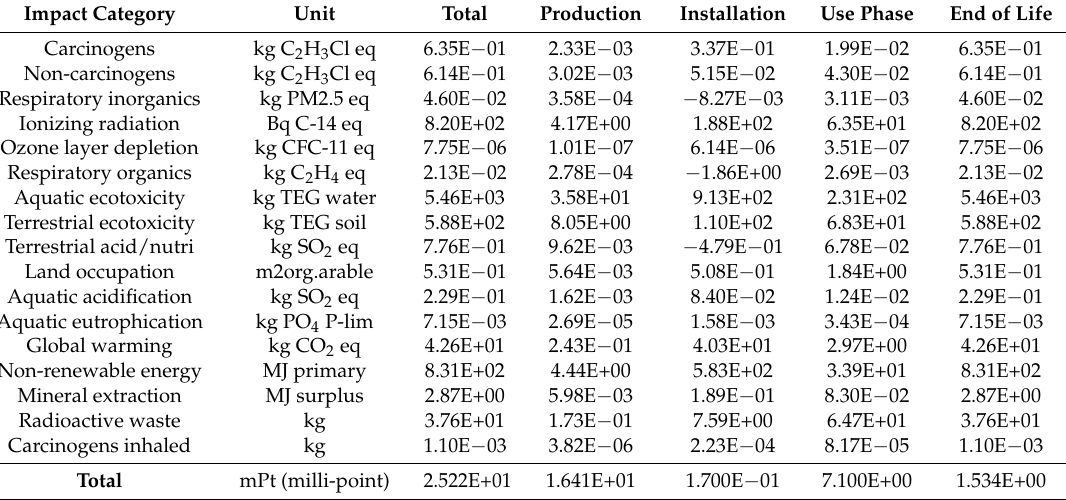
Table 2. Characterized LCIA results of 1 m 2 of nanoTiO 2 self-cleaning coated ( IMPACT 2002+ Method